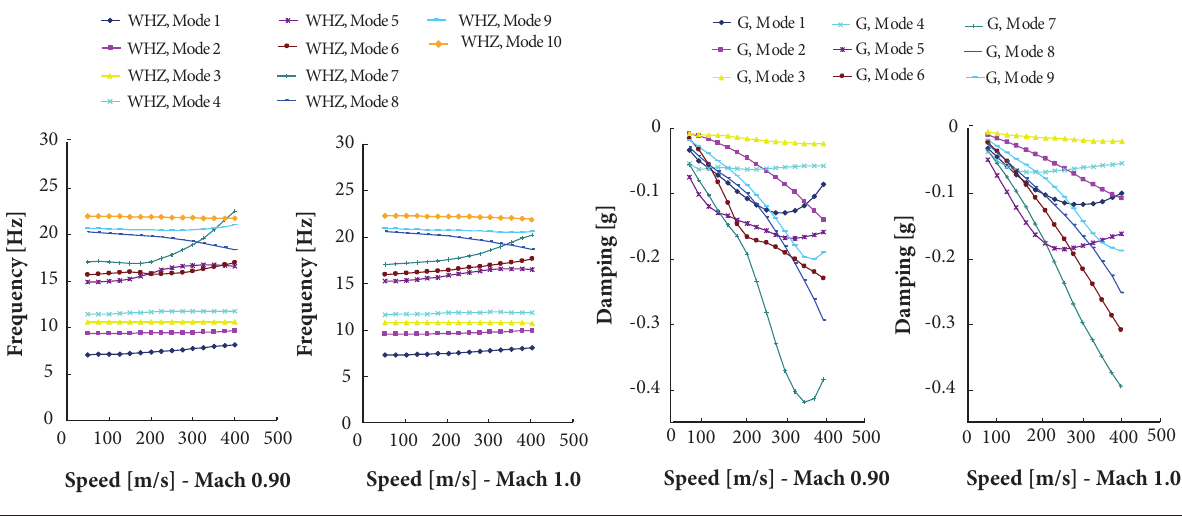
Figure 5. Non-matched aeroelastic analysis results — high subsonic range.